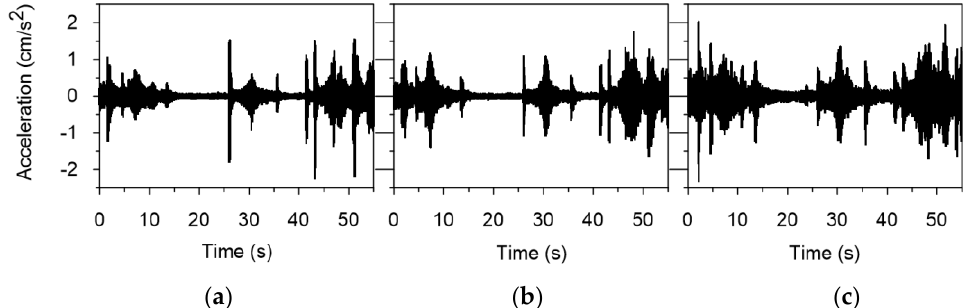
Figure 10. The acceleration-time histories registered at point P7a in ( a ) longitudinal direction, ( b ) transverse direction, ( c ) vertical direction.